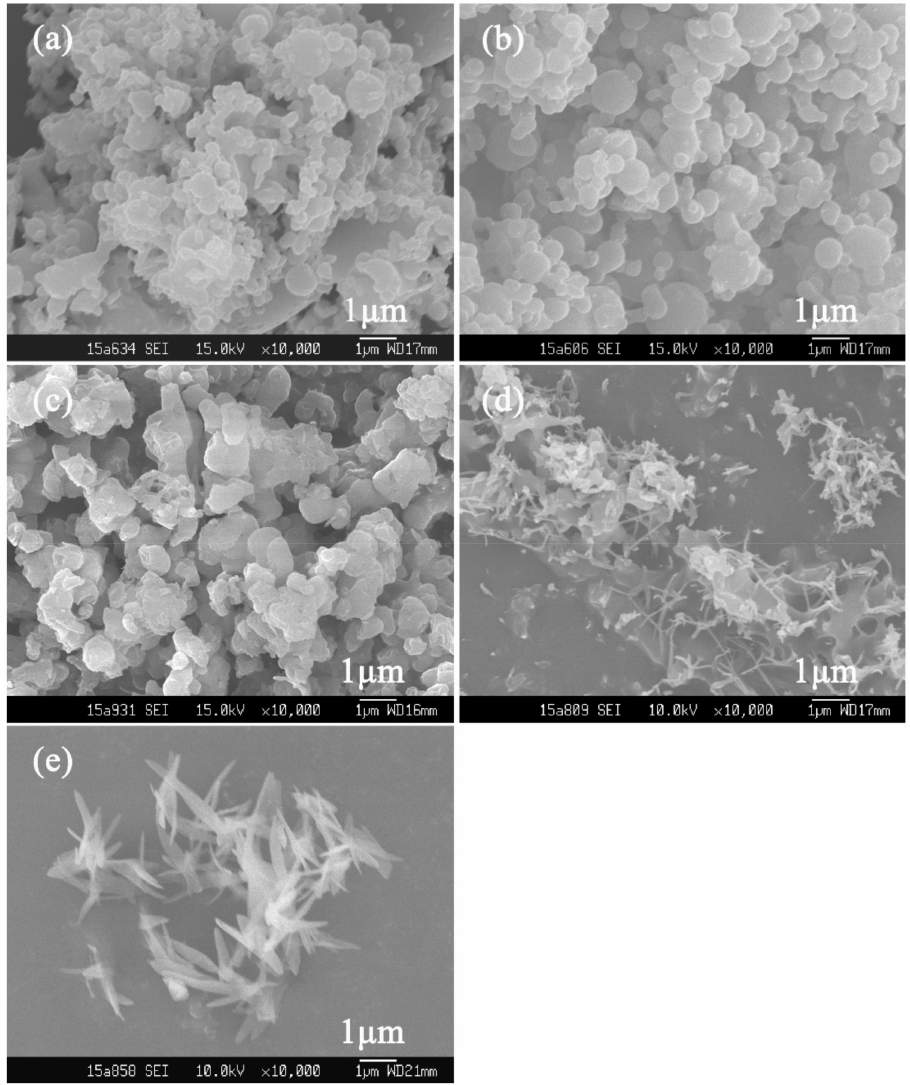
Figure 2. SEM images of a berberine-loaded particle (BP) prepared under a different mole ratio ( λ ) of BBR to β -CD via solution-enhanced dispersion by supercritical fluids (SEDS): ( a ) 1:2, Sample 1; ( b ) 1:1, Sample 2; ( c ) 3:1, Sample 3; ( d ) 5:1, Sample 4; and ( e ) BBR only, Sample